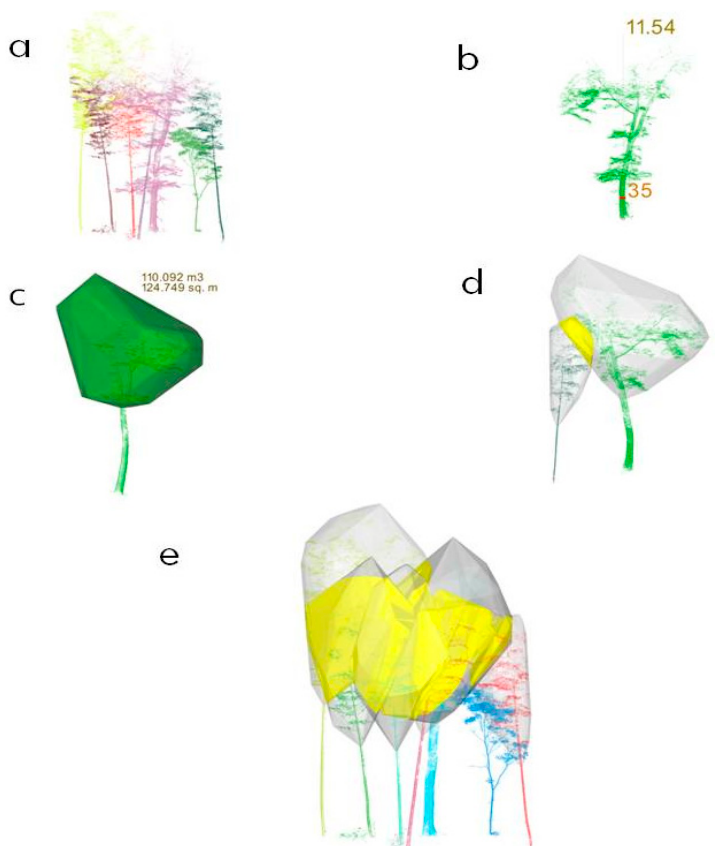
Figure 2. Extracting overlapping crown volume. ( a ) Overlap (volume) between the canopies of a broad-leaved tree and of bamboo. ( b ) Condition of the canopy, diameter at breast height, and height of broad-leaved tree. ( c ) Surface area and volume of canopy of broad-leaved tree. ( d ) Overlap (volume) between the canopies of a broad-leaved tree and of bamboo. ( e ) Overlap (volume) between a broad-leaved tree and bamboo surrounding the tree.